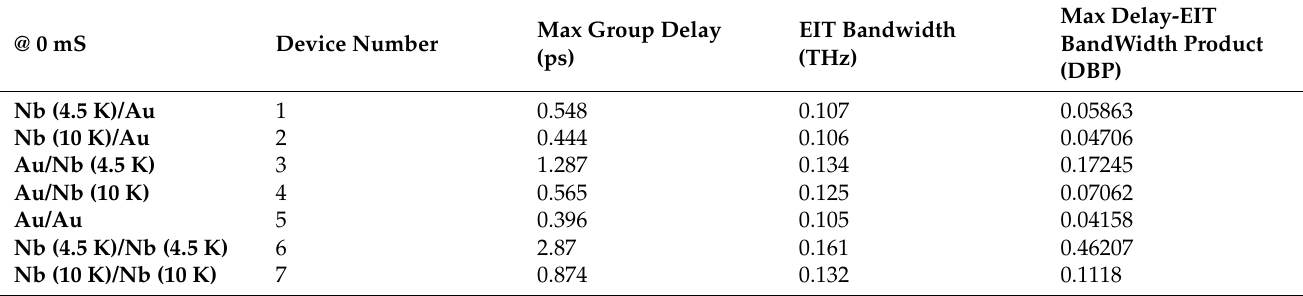
Table A1. Maximum group delay, EIT bandwidth, and maximum group delay-EIT bandwidth product (DBP) of different hybrid circuits at σ 0 = 0 mS.